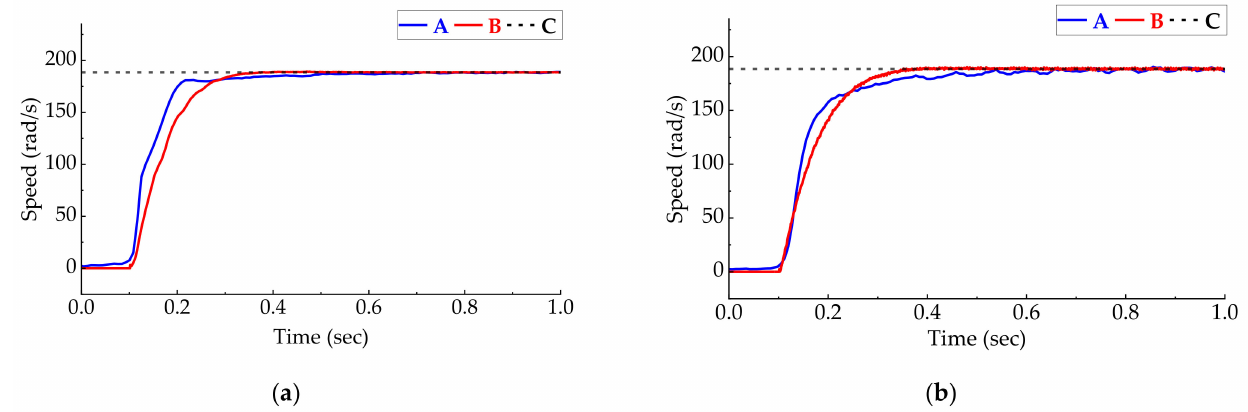
Figure 10. ( a ) Experimental results of PMSM control system based on PAEKF; ( b ) experimental results of PMSM control system based on